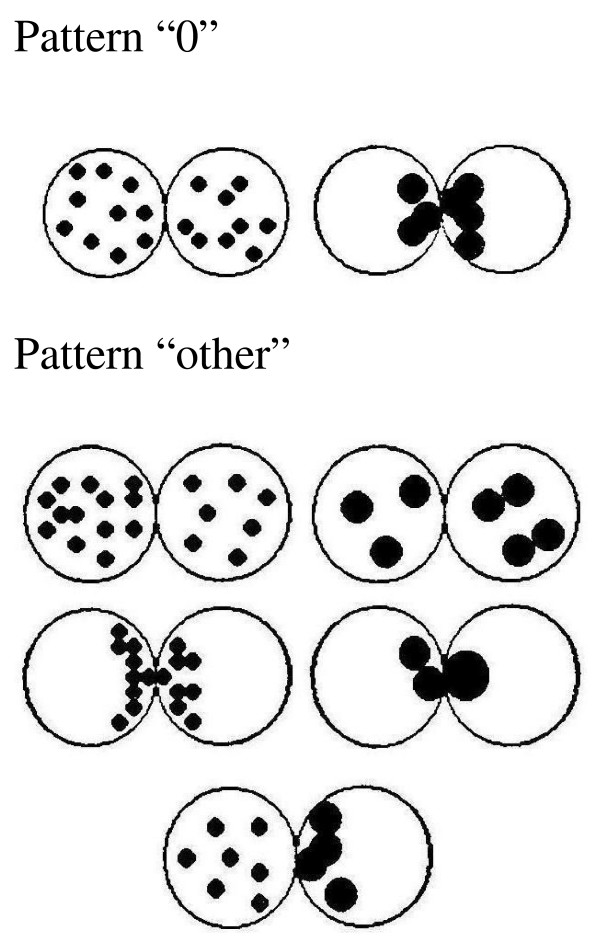
Simplified classification of pronuclear morphology originally published by Tesarik and Grecco [6]. Pattern "0": Zygotes exhibiting the same number of small nucleolar precursor bodies (NPB) evenly distributed in the nucleus or large NPB with polarized distribution between the two pronuclei. Pattern "other": All other non-symmetrical alignments of the NPBs including different numbers of NBPs.